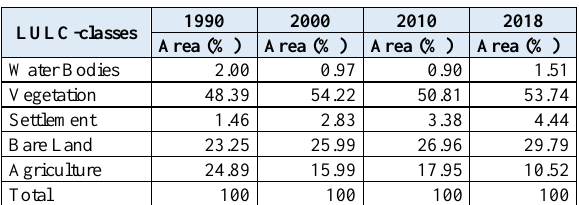
Table 1: LULC distribution of Kailali area throughout